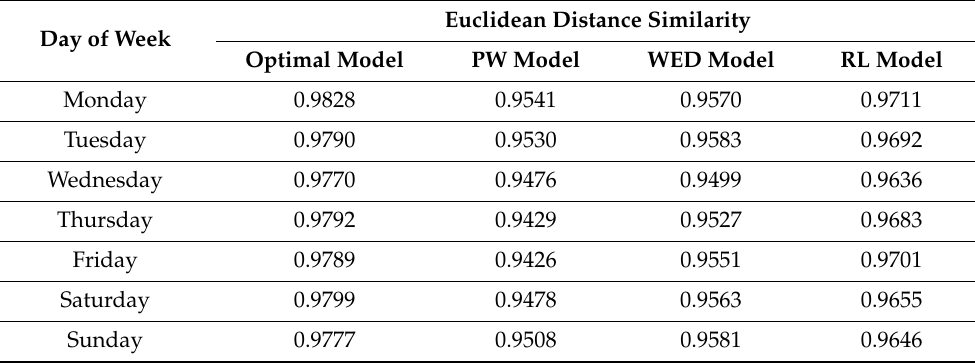
Table 5. Similar day selection performance results by the day of